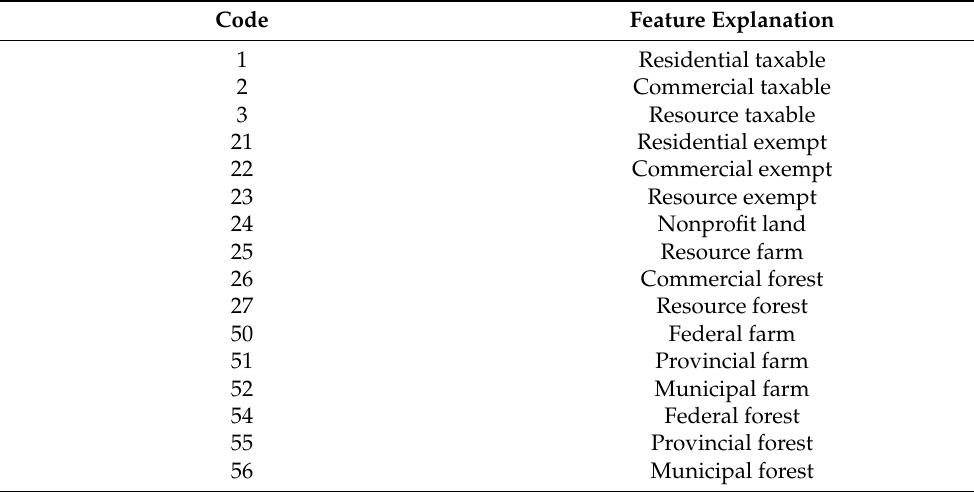
Table 3. Assessment Value Classification Code taken from the Nova Scotia Property Records Database (adapted from Province of Nova Scotia